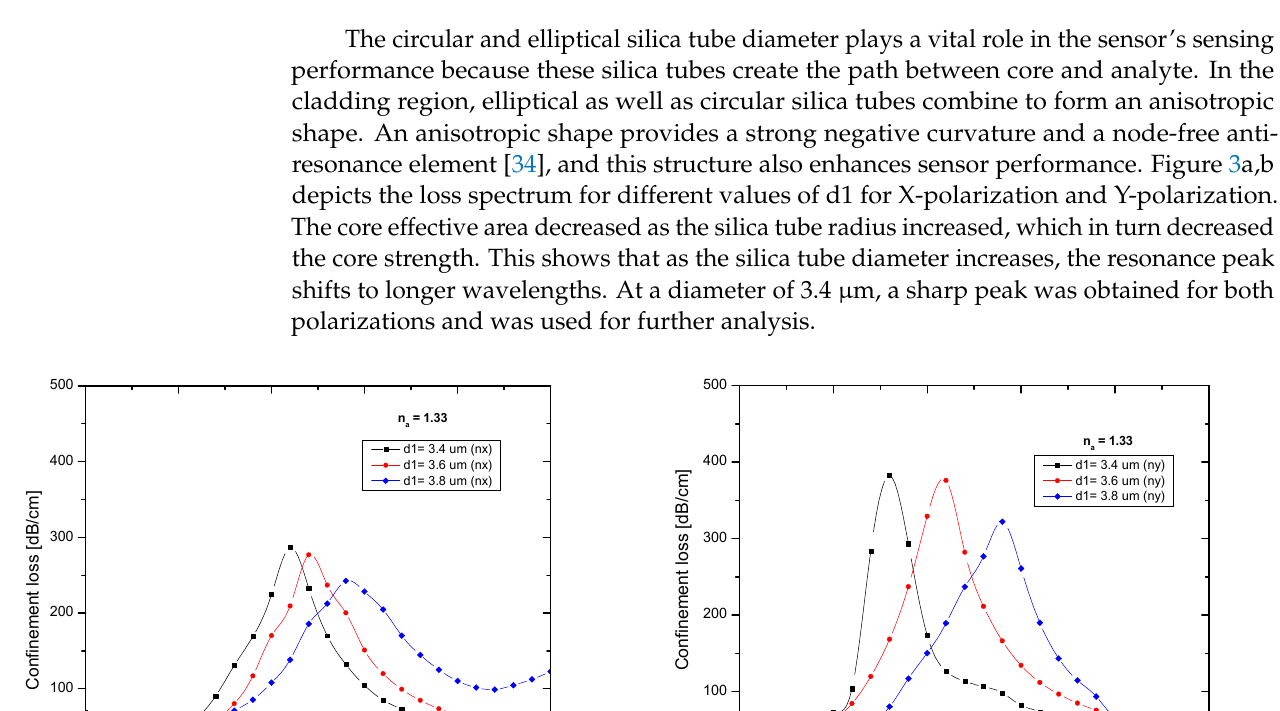
Figure 2. Confinement loss characteristics for different gold layer thicknesses for ( a ) X-polarization and ( b ) Y-polarization.